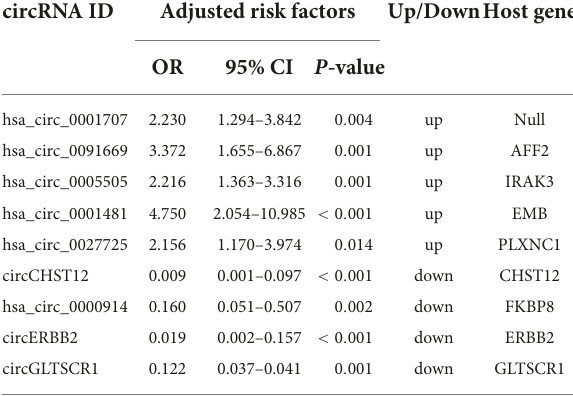
TABLE 3 Logistic regression analysis to identify circRNAs as independent predictive factors of intracerebral hemorrhage (ICH). circRNA